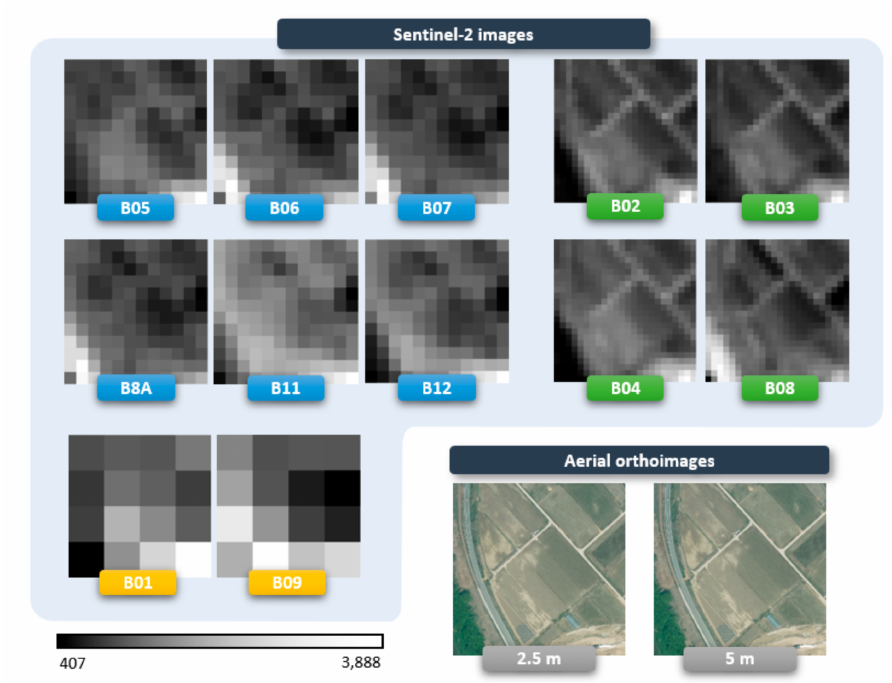
Figure 4. Example of training sets (Input: {B2 B3 B4 B8}: 10 m, {B5 B6 B7 B8A B11 B12}: 20 m, and {B1 B9}: 60 m, output: aerial orthoimages 2 × for 5.0 m, 4 × for 2.5